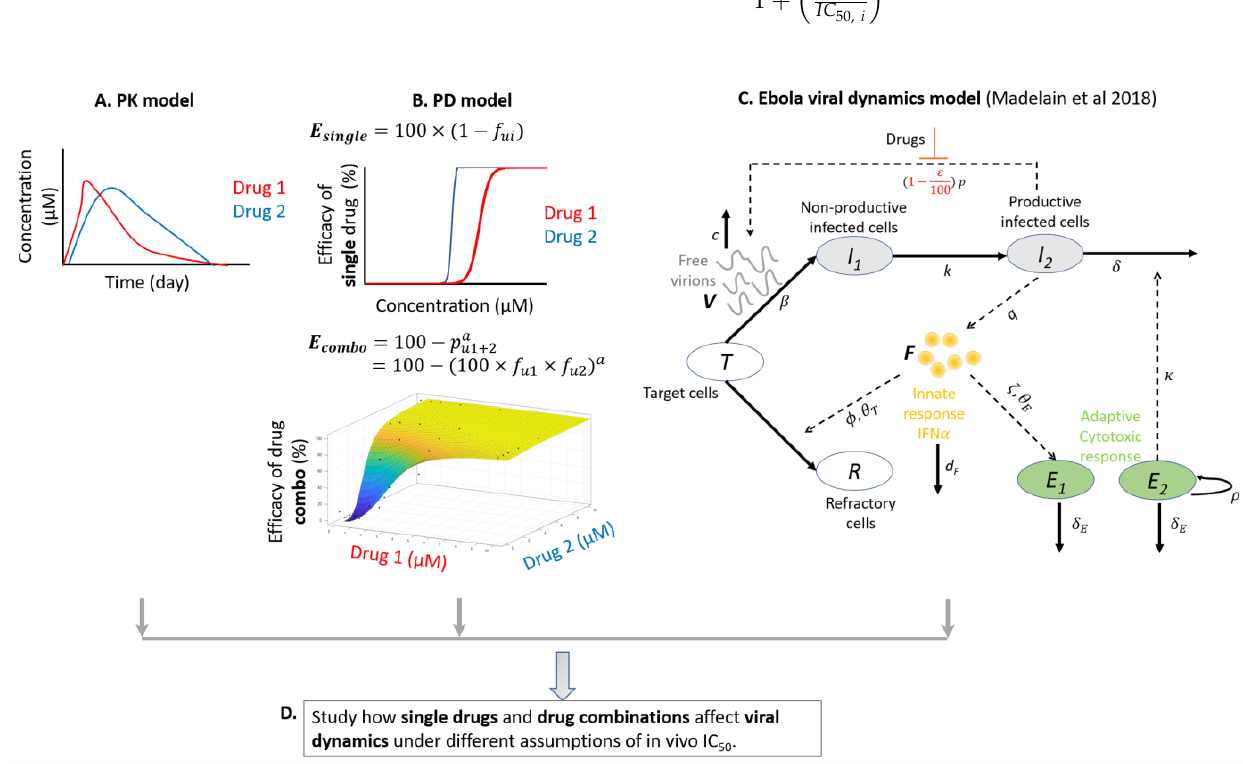
Figure 1. Frameworks for studying the advantage of drug combinations against EBOV infection. ( A ) PK modeling (drug concentration in human plasma or serum over time). ( B ) PD modeling (drug concentration dependent inhibition of EBOV replication) of single drugs (top) and drug combinations (bottom). ( C ) EBOV dynamics model (plasma viral load over time in cynomolgus macaques, schematic styled after Figure 3 in [29]). ( D ) The PK, PD (single drugs and drug combinations), and EBOV viral load dynamics model, are combined under different assumptions of in vivo IC 50 s (the plasma concentration of drug required to inhibit EBOV replication by 50%, the true in vivo drug potency against EBOV, in humans) to predict EBOV viral load trajectories in humans in the presence of single drugs or drug combinations. Panel C was adapted from Reference [29]. See text for sources of input data.